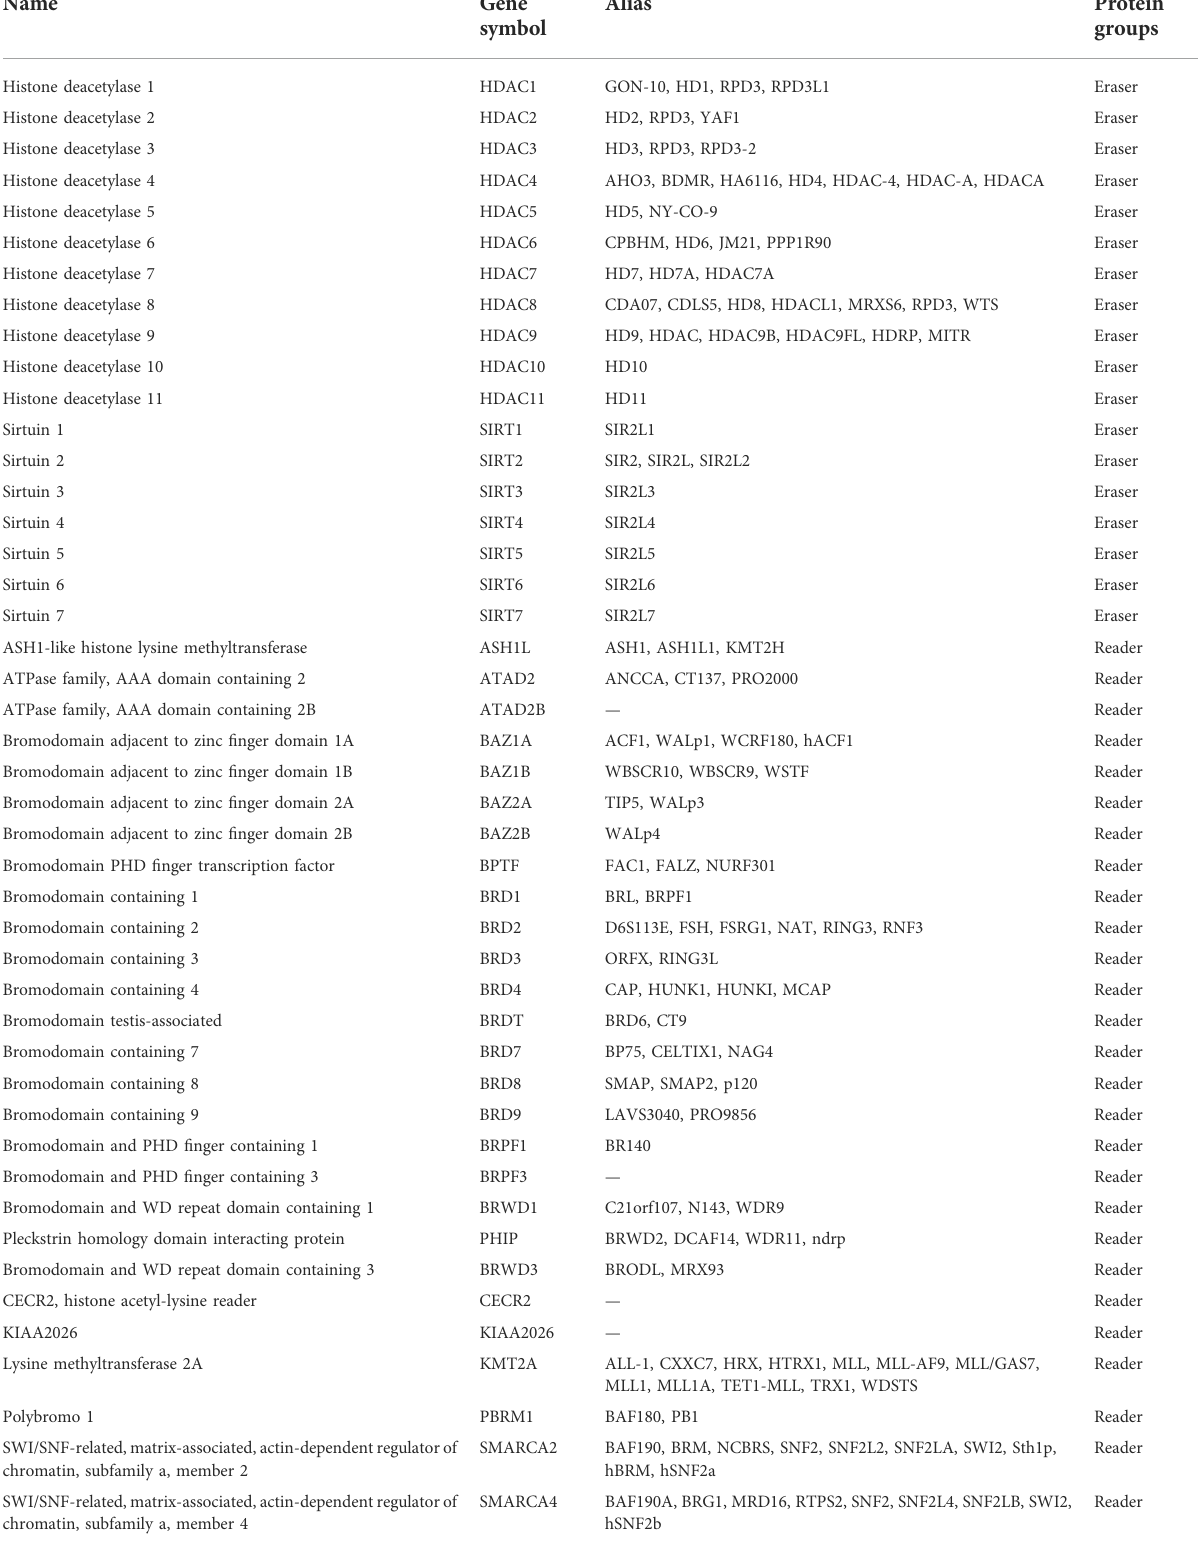
TABLE 3 Classi fi cation, formal names and aliases of